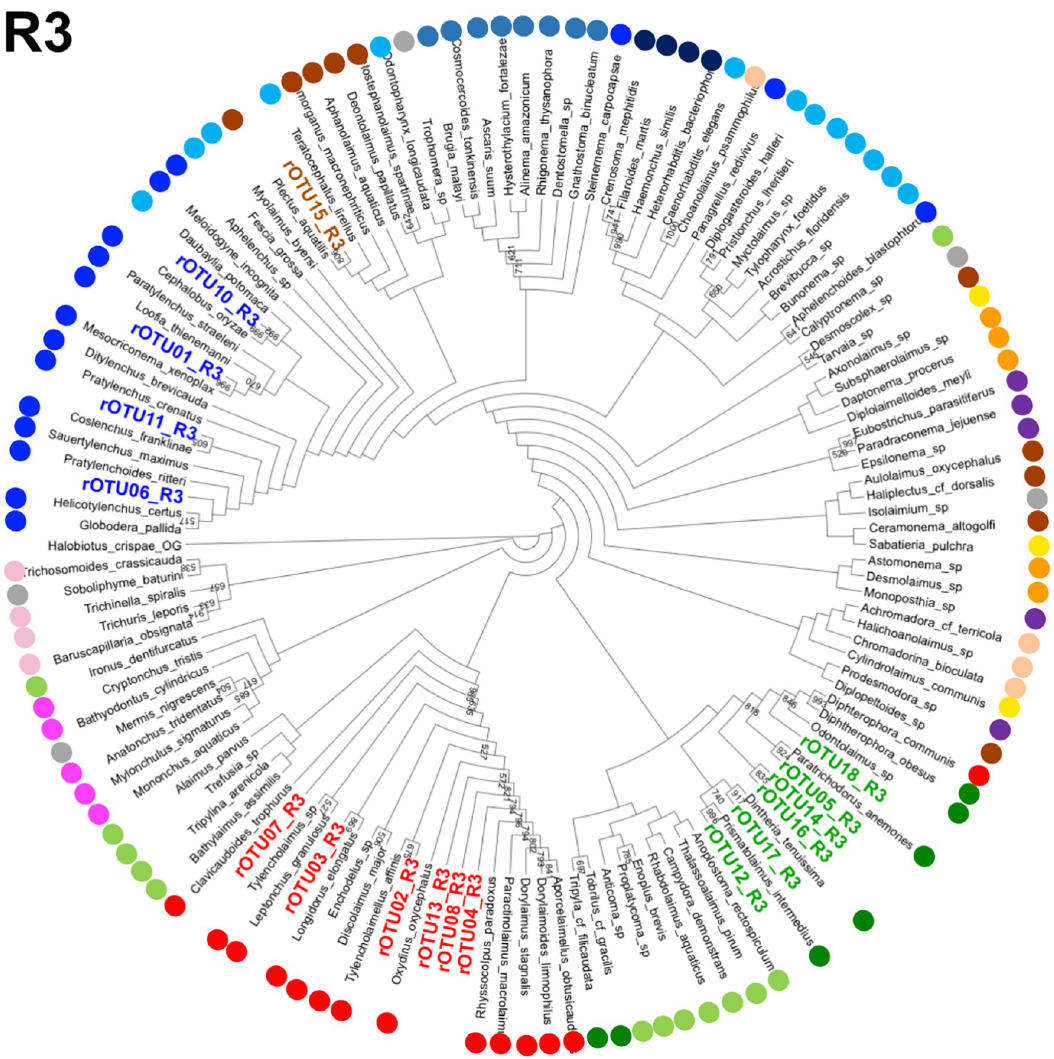
Fig 7. A cladogram of phylogenetic tree generated by regional (region 3) SSU nucleotide sequences from reference nematode species and regional rOTUs. The phylogenetic trees were prepared using regional sequences of the reference nematode species and the regional rOTUs corresponding to region 3 (R3) as described in Materials and methods. Orders of the reference species are indicated by colored dots, as shown in the legend for Fig 5.